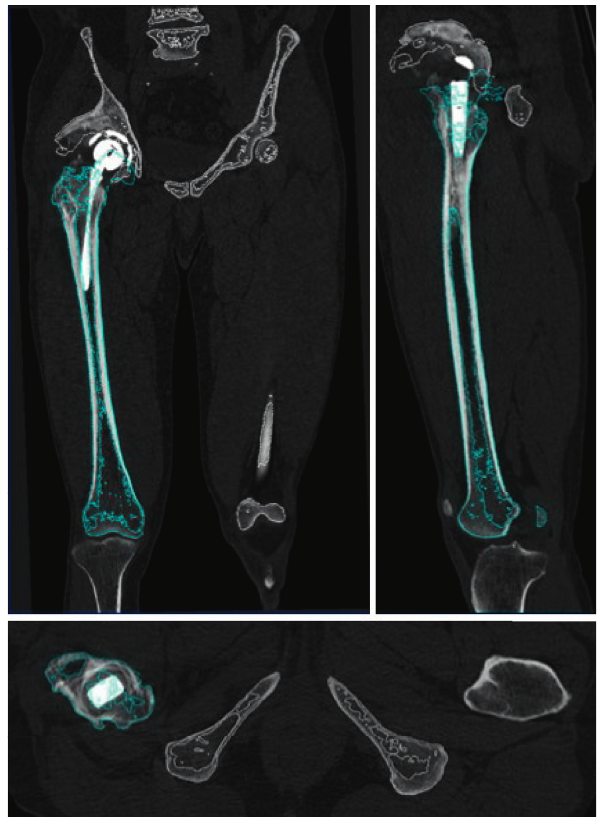
Figure 3: Image matching of the preoperative and postoperative CT images. Preoperative CT images (blue line) were fused to the postoperative images (white line) automatically as bone surfaces